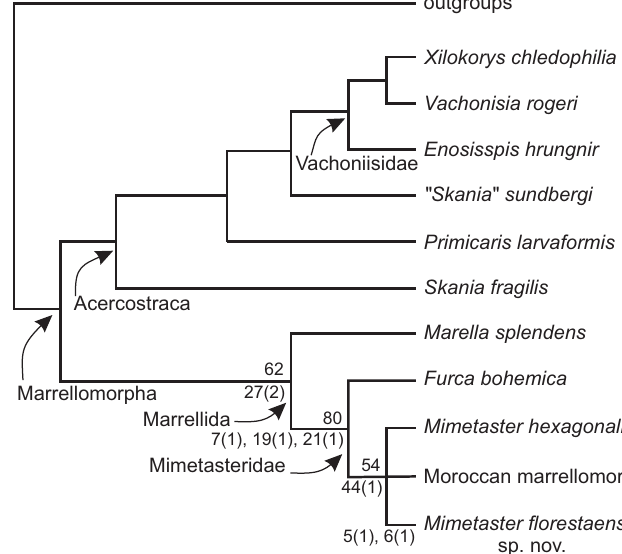
Fig. 3. Cladogram showing phylogenetic relationships of Marrellomorpha, incorporating the new taxon here described, CI = 0.825; RI = 0.857, 63 steps with characters of equal weight. Length of tree with implicit weighting equal to 1.500 (K = 5), 2.550 (K = 3) and 4.833 (K = 1). In the Marrellida clade, the numbers on the right represent apomorphies, with the character state between parentheses.